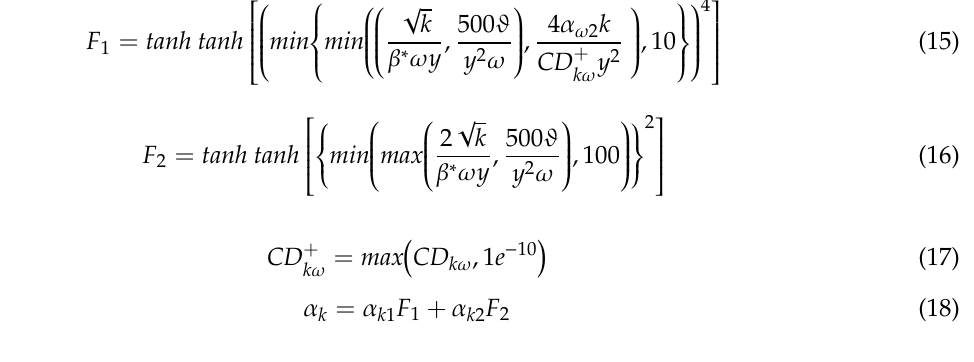
Table 3. k − ω SST model